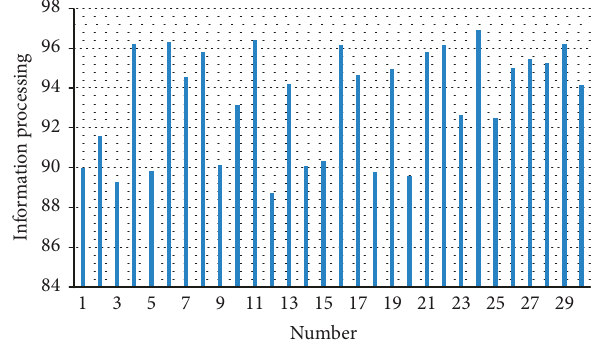
Figure 8: Statistical diagram of the information processing effect of the multimedia network information processing system based on the fast K neighbor